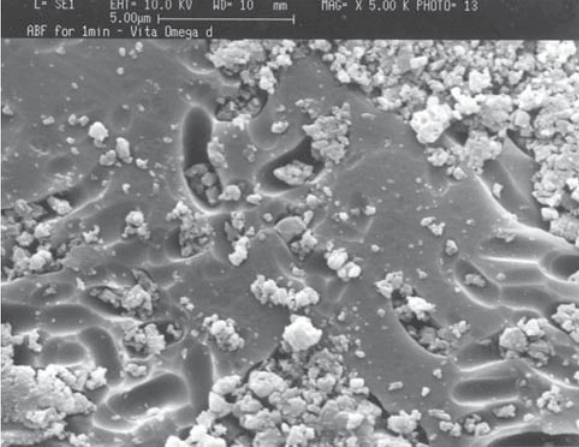
FIGURE 2- Photomicrographs of ABF-etched Vita Omega dentine ceramic (Vita Zahnfabrik, Bad Sackingen, Germany), a leucite based feldspathic ceramic. This acid produces mostly linear defects (grooves) by attacking existing surface cracks, leucite-induced cracks, and phase boundaries. From Della Bona and Anusavice 25 , 2002.